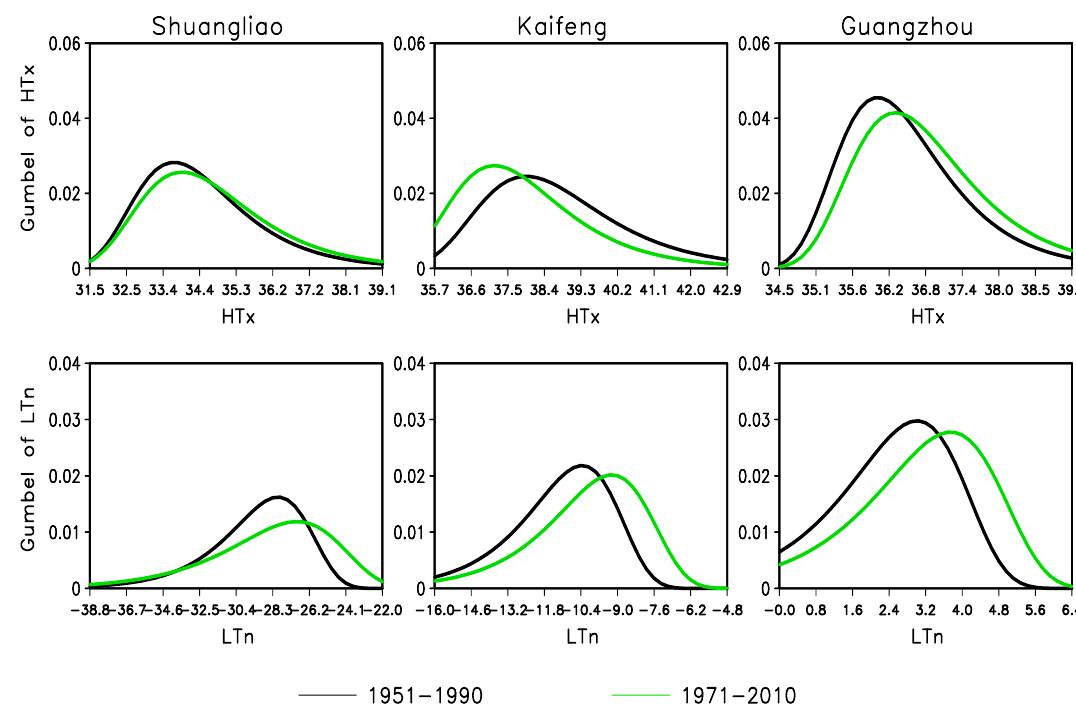
Fig. 3 Gumbel distribution derived from observed HTx (Top panel) and LTn (Bottom panel) samples of three selected stations in two periods (The black line is for P1 and green for P2)